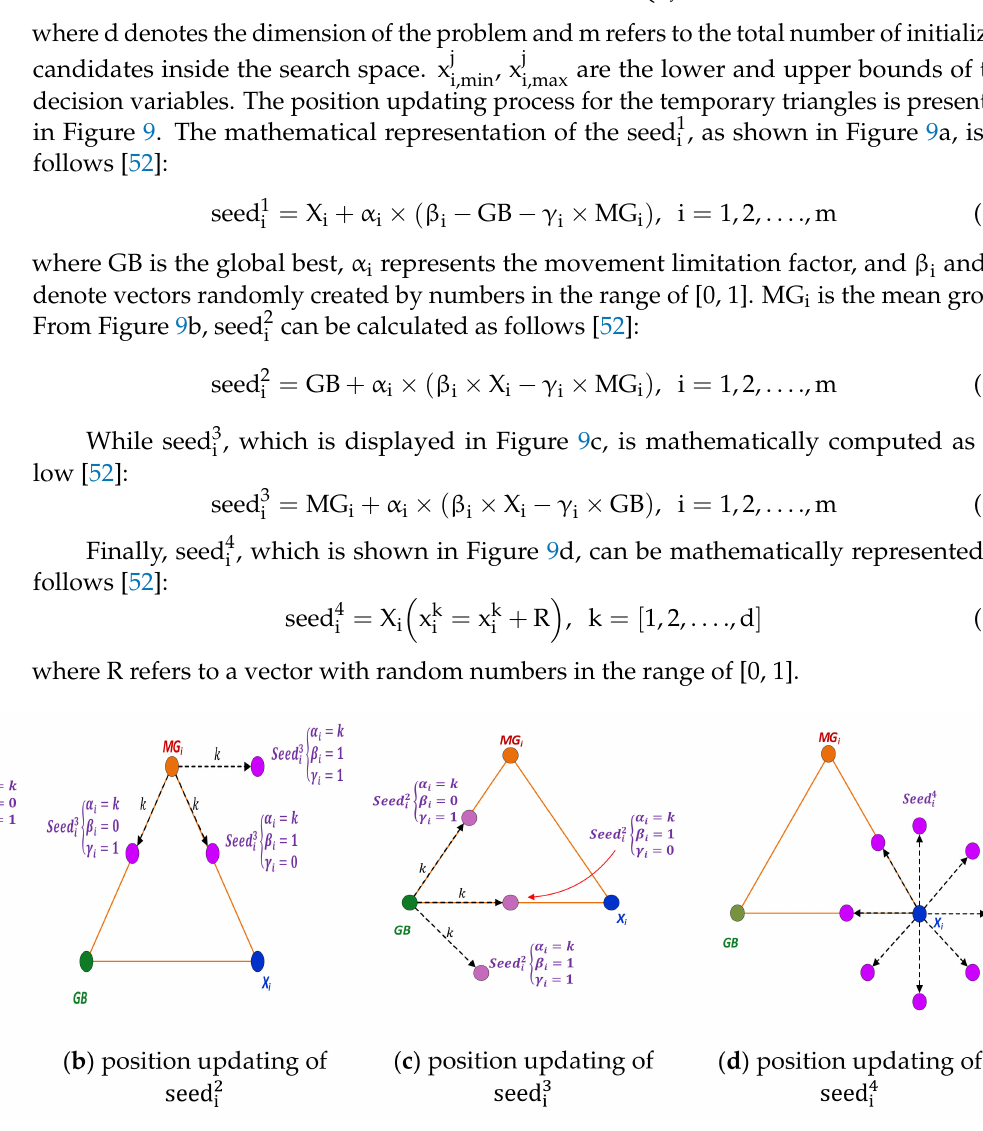
Figure 9. Position updating process for the temporary triangles